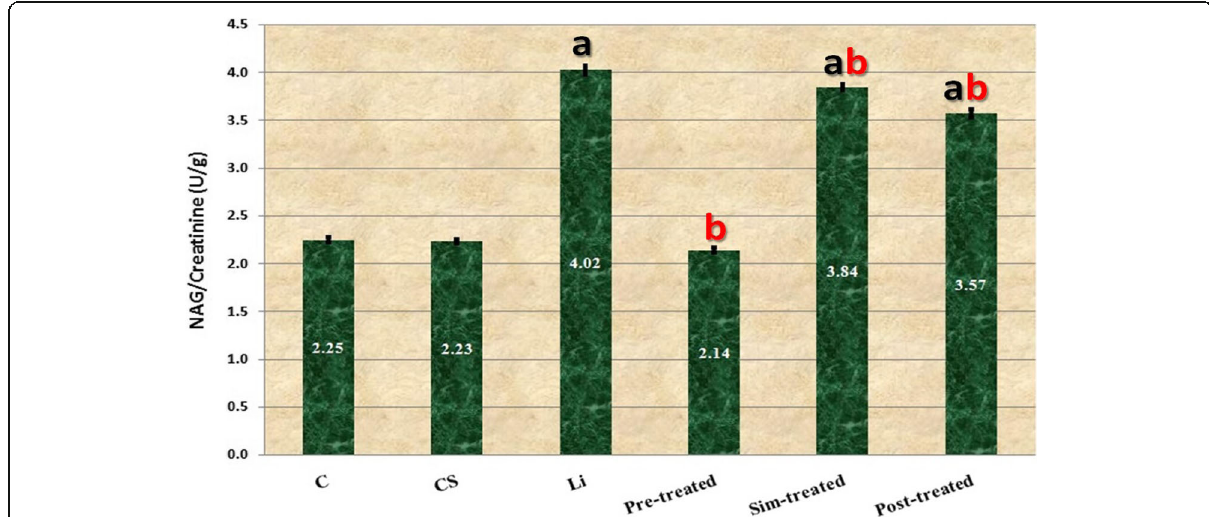
Fig. 1 Prophylactic and therapeutic effect of chitosan on urinary NAG/creatinine (N-acetyl- β -D-glucosaminidase/creatinine) ratio against Li 2 CO 3 -induced renal toxicity in rats. Bars represent the group means±SE. a Significant difference from control group at P <0.05. b Significant difference from Li-treated group at P <0.05